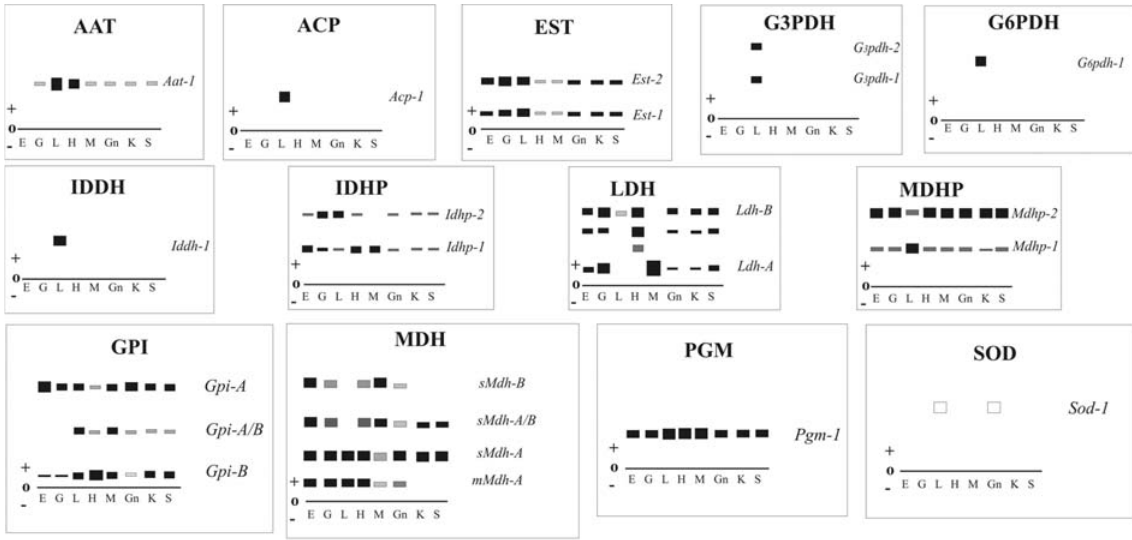
Figure3 -Electrophoreticpatternand locus designationfor13enzymesystemsof Astyanaxaltiparanae fromtheUpperParanáRiverandRibeirãoFicha, Paraná, Brazil. Type of tissue: E = eye; G = gill; L = liver; H = heart; M = white muscle; Gn = gonad; K = kidney; S =